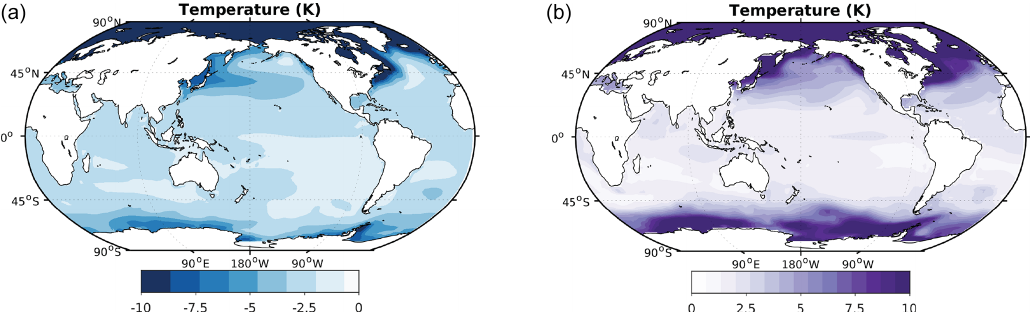
Figure 7. Annual mean temperature lgm–piControl anomaly (a) and model spread (b) (in K).